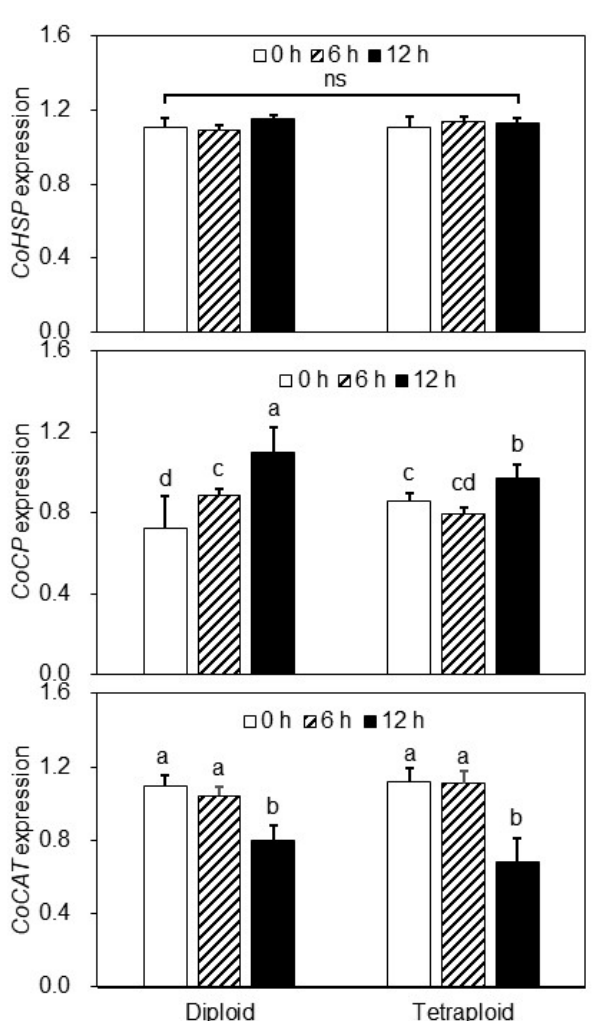
Figure 7. Effect of high temperature treatment on the expression of heat stress-responsive genes ( CoHSP , CoCP , and CoCAT ) in diploid and tetraploid (line 81-12) C. officinale plants. CoActin was used as a reference gene. Data represent mean ± SE. Different letters indicate significant differences among treatments in diploids and tetraploids ( p < 0.05; Duncan’s multiple range test). ns, non- significant.